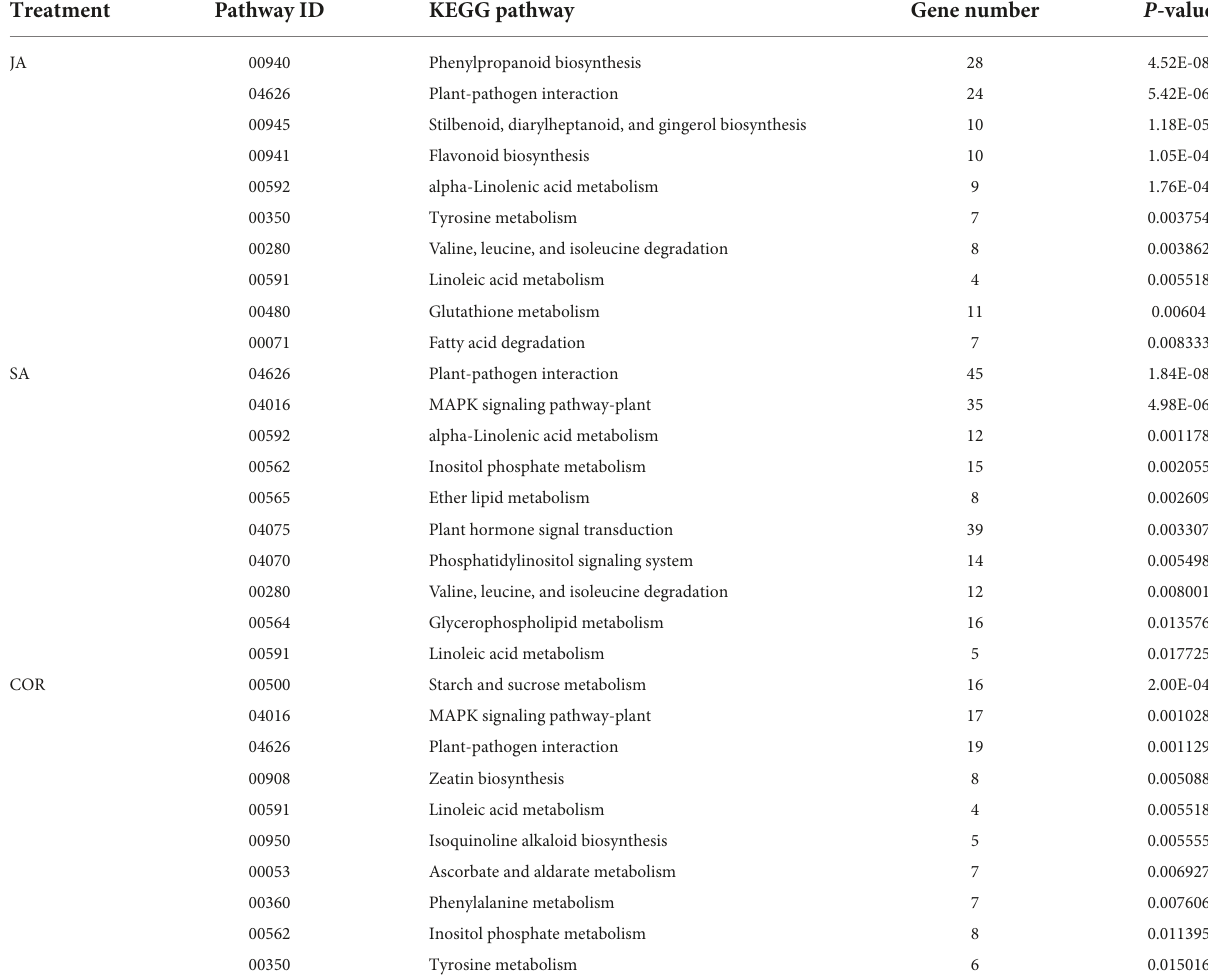
TABLE 3 The Kyoto encyclopedia of genes and genomes (KEGG) pathways (top 10) enriched by up-regulated differentially expressed genes (DEGs) under the three treatments. Treatment Pathway